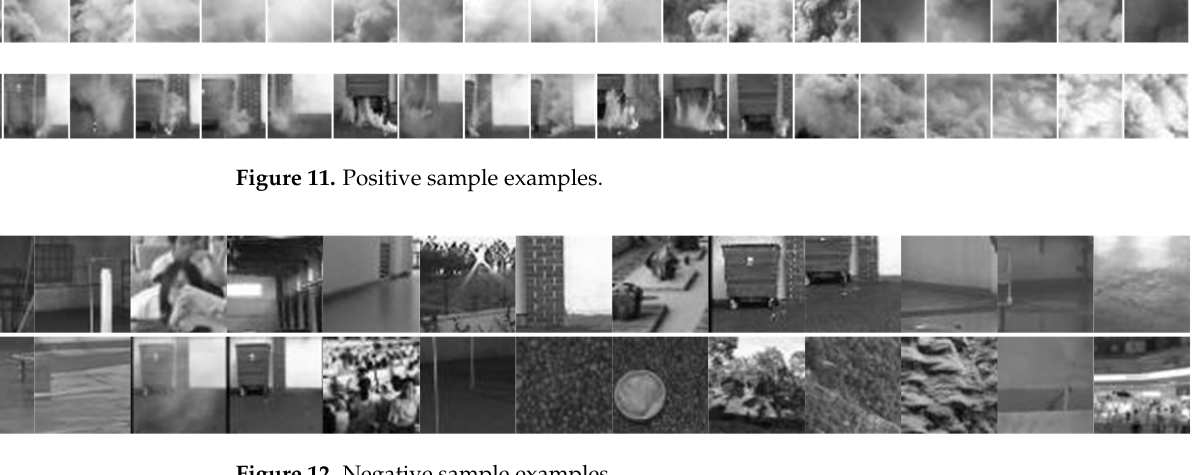
Figure 12. Negative sample examples.